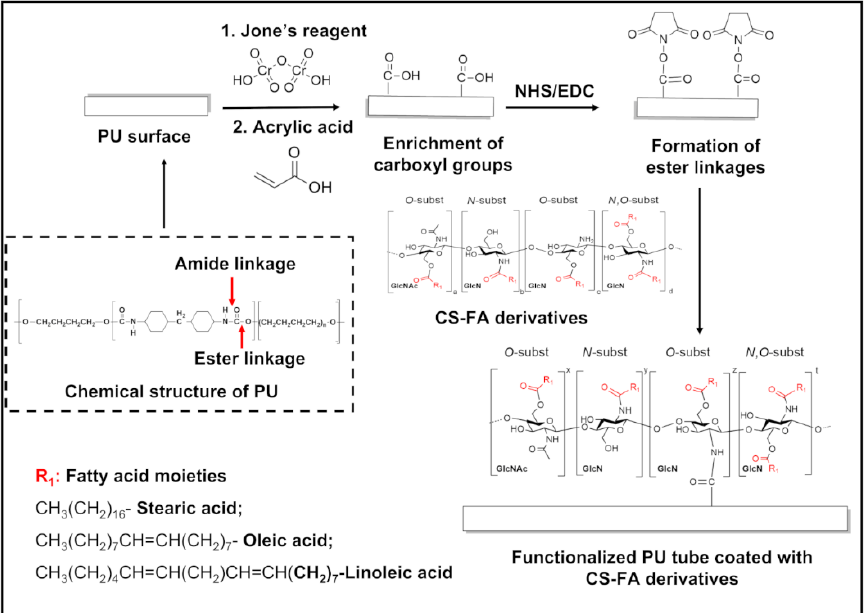
Figure 4. Schematic representation of the modification mechanism of CS and CS-FA derivatives coated onto the surface of PU stents.